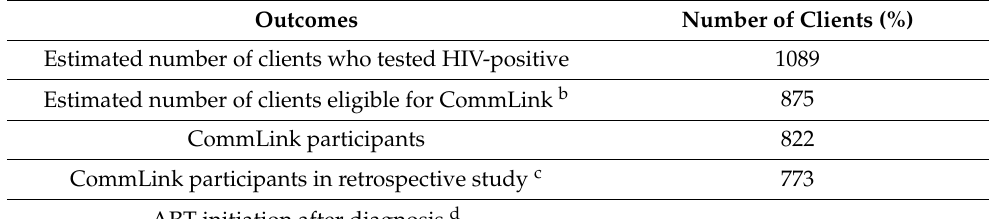
Table 1. CommLink enrollment, ART initiation, and ART retention outcomes, Manzini Region, Eswatini, March 2016–March 2018 a .